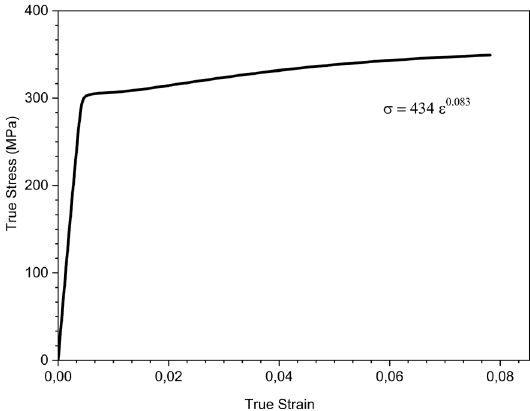
Figure 2. Stress–strain curves of AA6061-T6 aluminium alloy.